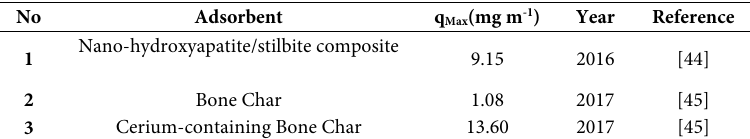
Table 2. Comparison of adsorption capacity of some adsorbents for